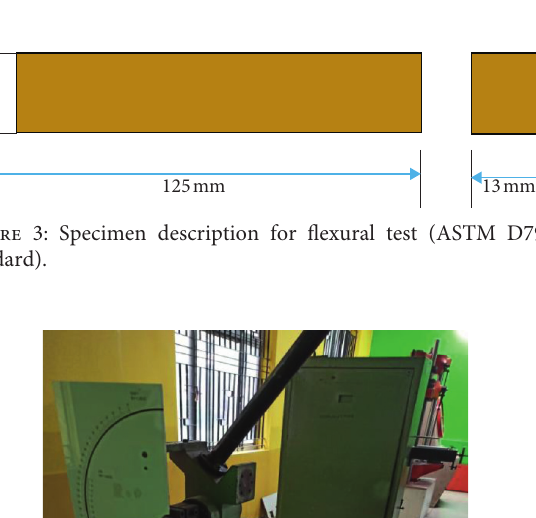
Figure 6: Tensile strength of the composite